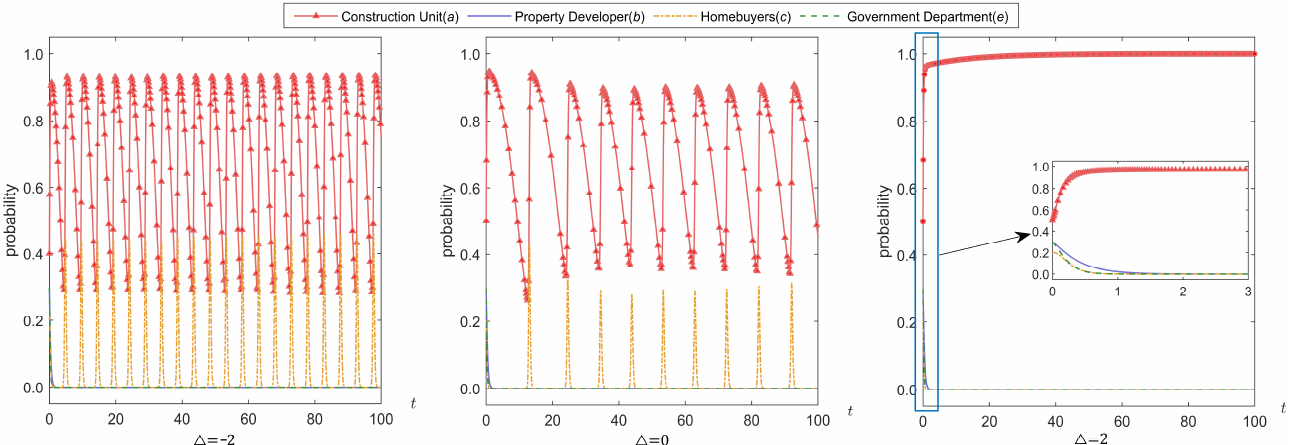
Figure 8. Process of the quadripartite strategy evolutionary game under the government punishment mechanism.